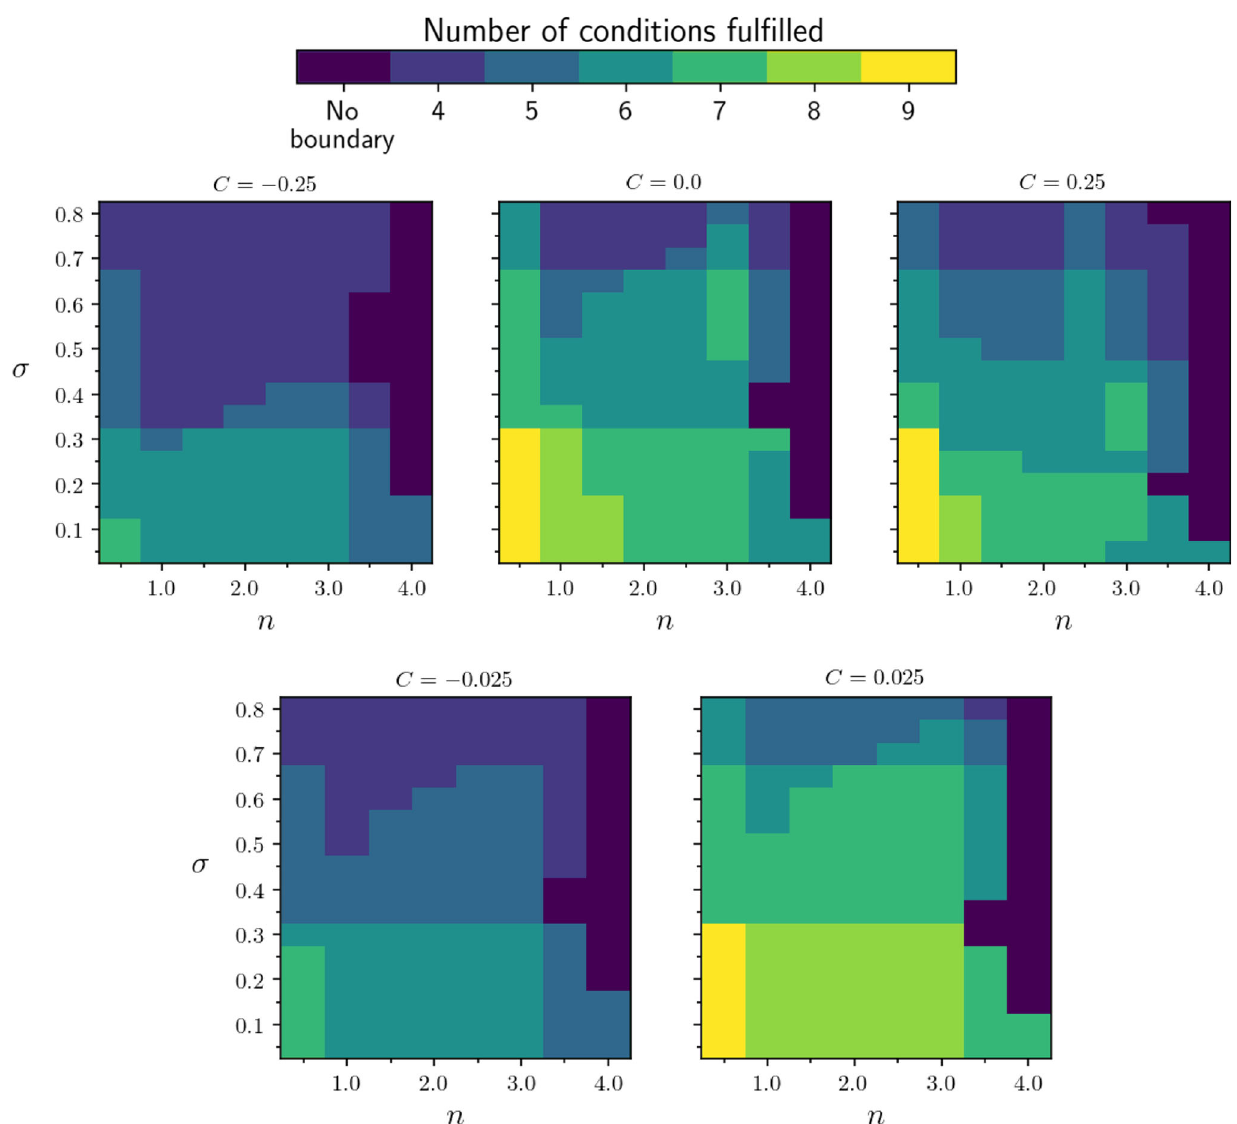
Fig. 10 Parametric space for the Lane–Emden equation (α = β = 0 ) with energy density (bottom plates in Figure 11), for several values of anisotropic factor C . Isotropic case, C = 0 . 0, corresponds to Tooper’s